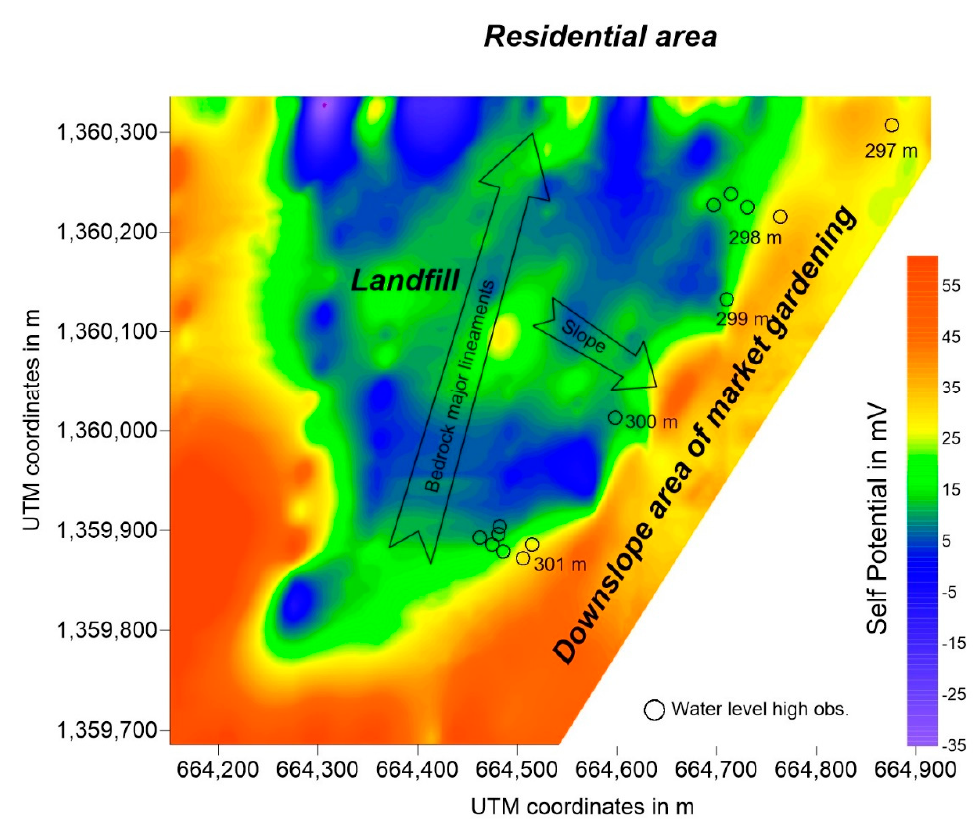
Figure 7. Kriged map of the distribution of self-potential values over the prospected area, major bedrock lineament direction, and water level high.